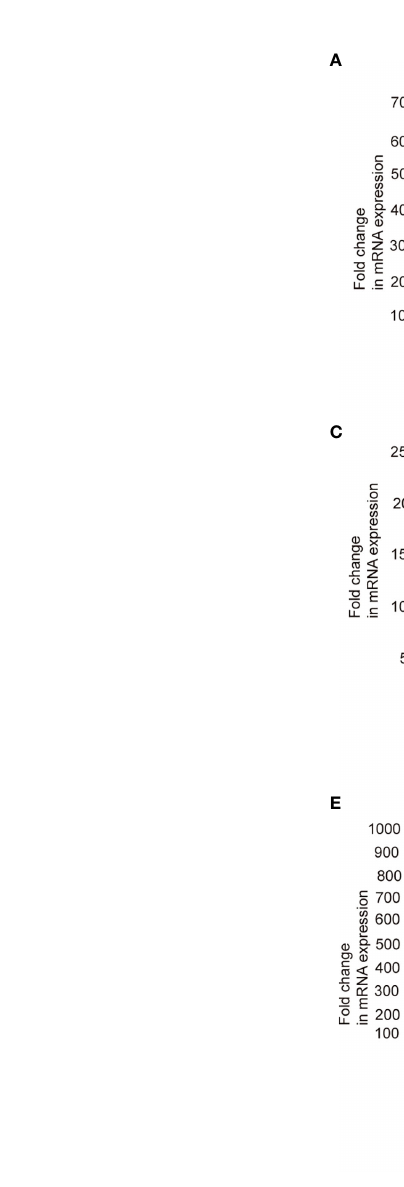
FIGURE 2 The expression levels of IFN- b (A, B) , IFN- l 1 (C, D) , and IFN- l 2 (E, F) mRNAs and proteins in basal media and cultured sinonasal epithelial cells 24, 48, and 72 h after RV 16 inoculation and poly(I: C) treatment, which were evaluated by RT – qPCR (A, C, E) and ELISA (B, D, F) . Data are mean ± SEM from 7 different epithelial donors. Normal ep + rhinovirus indicates that cultured normal epithelial cells were infected with RV. In fl am ep + rhinovirus indicates that cultured in fl ammatory epithelial cells were infected with RV. Normal ep + poly (I: C) means poly (I: C)- treated cultured normal epithelial cells. In fl am + poly (I:C) means poly (I: C)-treated cultured in fl ammatory epithelial cells. * indicates a signi fi cant difference between each